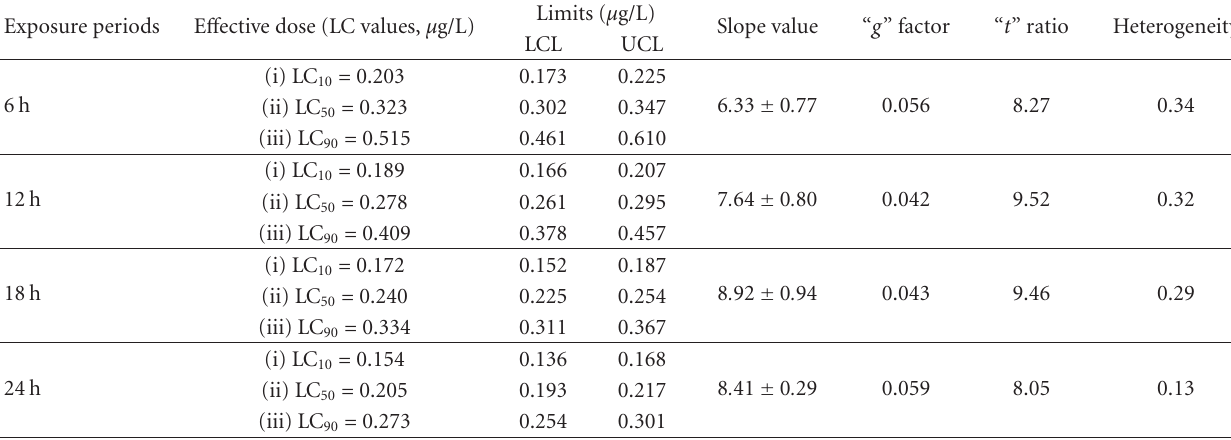
Table 1: Toxicity of cypermethrin against fingerlings of fish Labeo rohita . Exposure